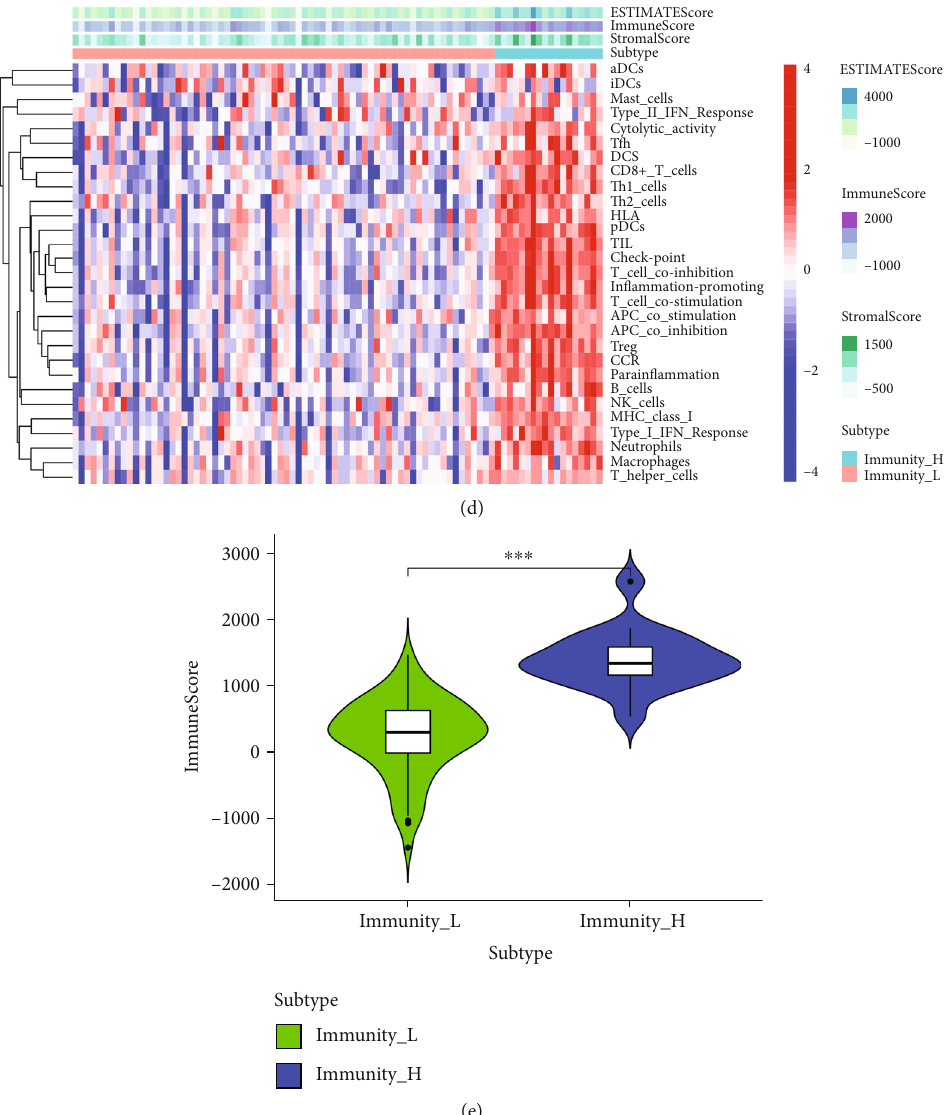
Figure 3: Elucidation of the immune cell in fi ltration landscape in OS. (a) ESTIMATE was used to evaluate survival in OS patients belonging to the high- and low-TME subgroups. (b) TSNE con fi rmed the rationality of ssGSEA grouping. (c) Based on the ssGSEA results, OS patients were divided into the immunity_ H and immunity_ L groups. (d) Landscape of the immune characteristics and TME in TCGA-OS cohort. (e) Correlation analysis between the ESTIMATE algorithm method and ssGSEA